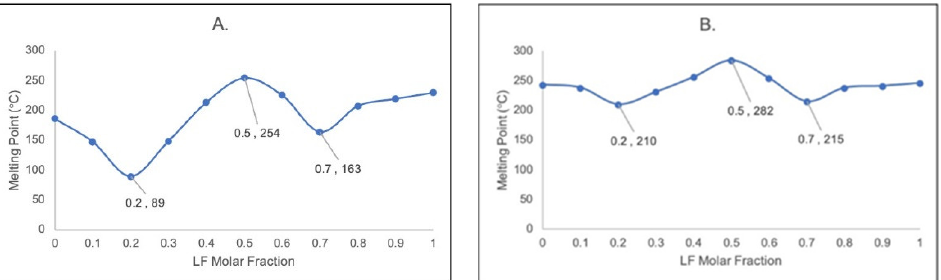
Figure 1. Binary phase diagram of ( A ) LF + 2,6-DHBA; ( B ) LF + 3,5-DHBA. Note: LF = levofloxacin; DHBA = dihydroxybenzoic acid.